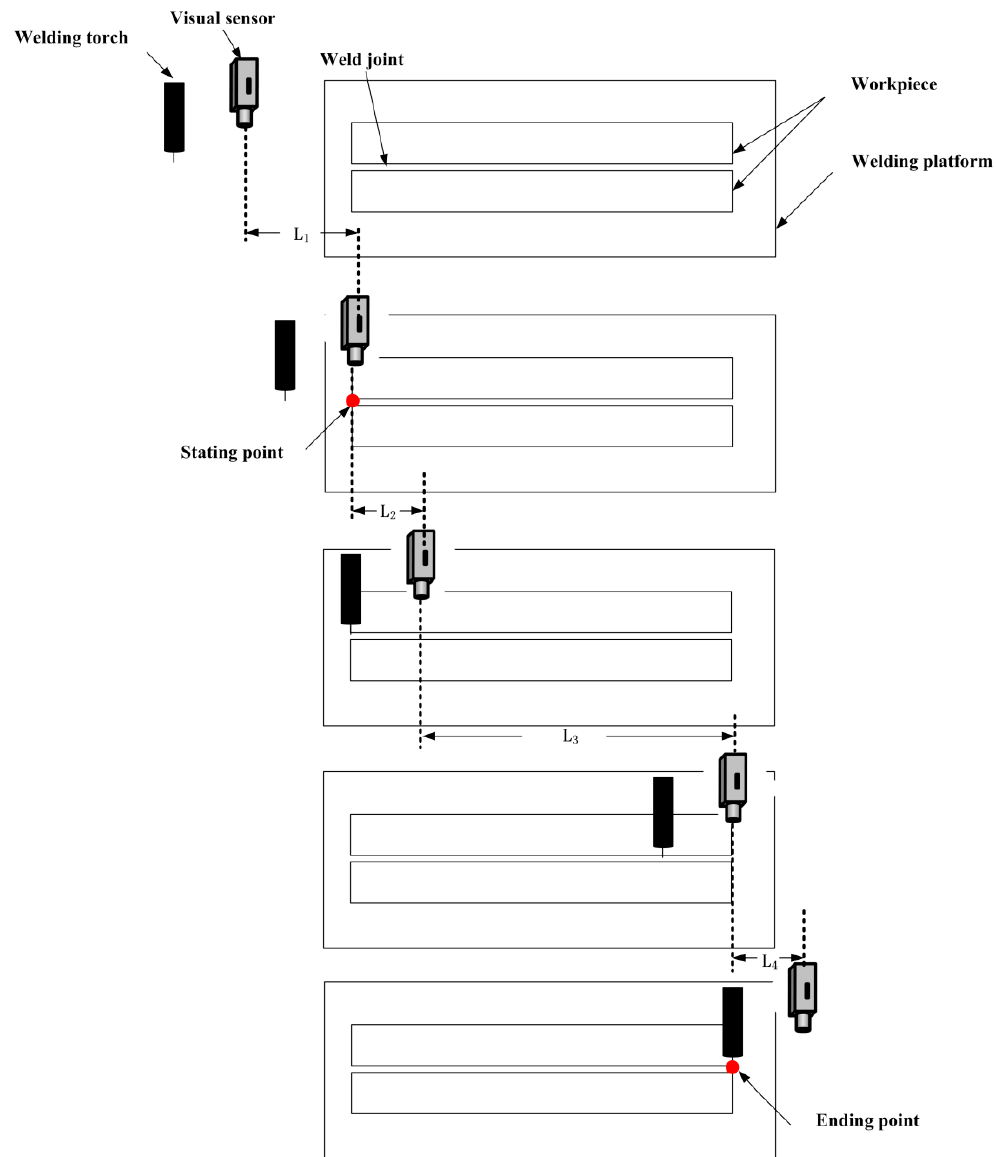
Figure 7. The relative position of the welding torch, visual sensor and the workpiece.